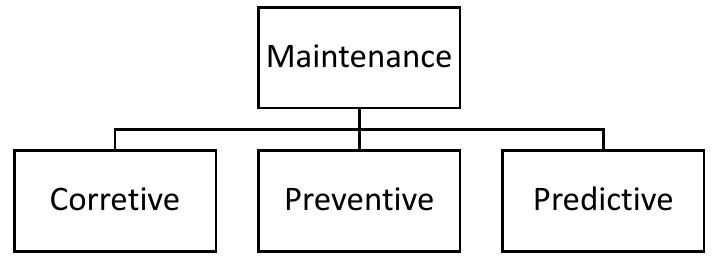
Figure 1. Three popular maintenance models.